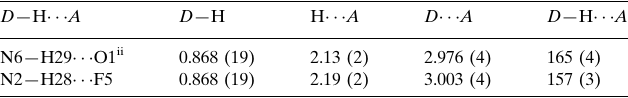
Hydrogen-bond geometry (A˚ , (cid:4)